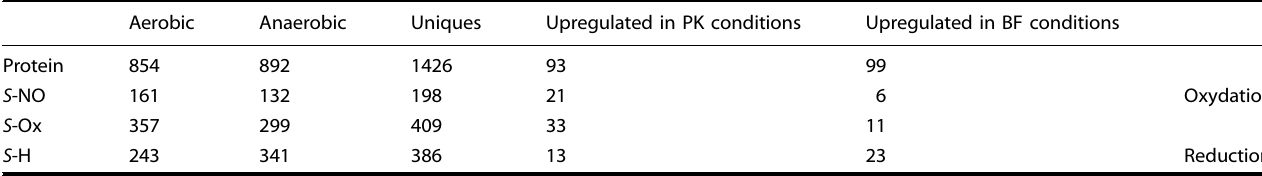
Table 1. Summary of the redox proteomics